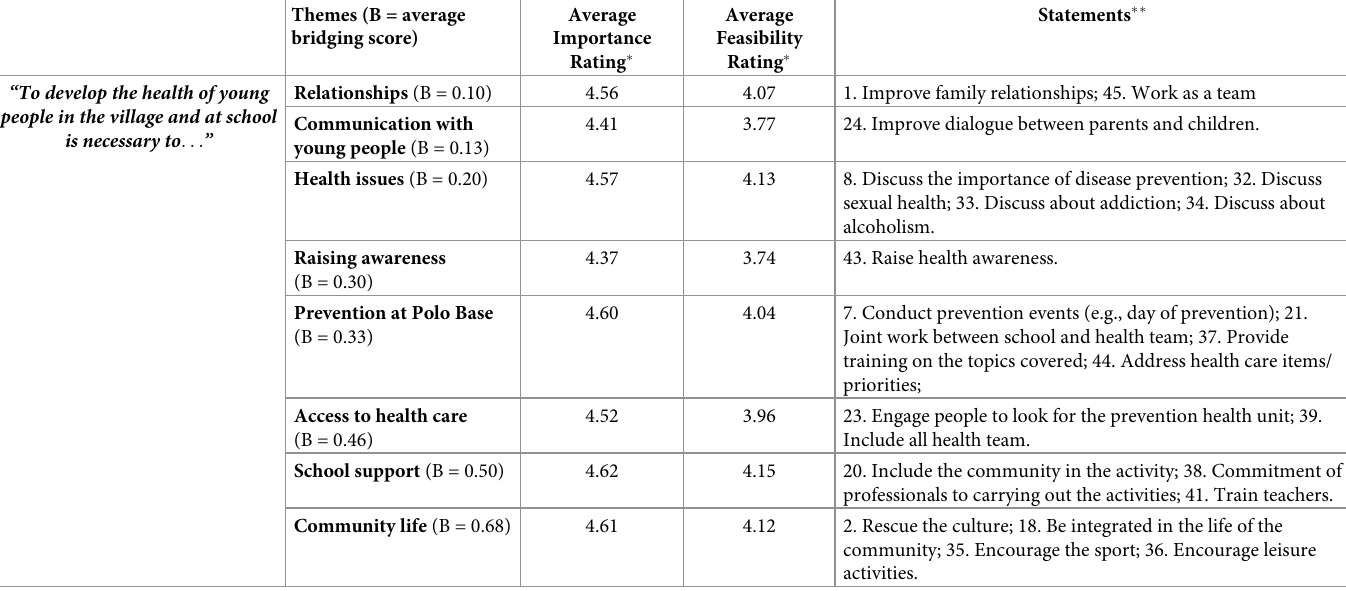
Table 2. Adults: Themes, bridging values, average importance and feasibility ratings and statements for adults based on their response to the prompt: ‘To develop the health of young people in the village and at school is necessary to ... ’